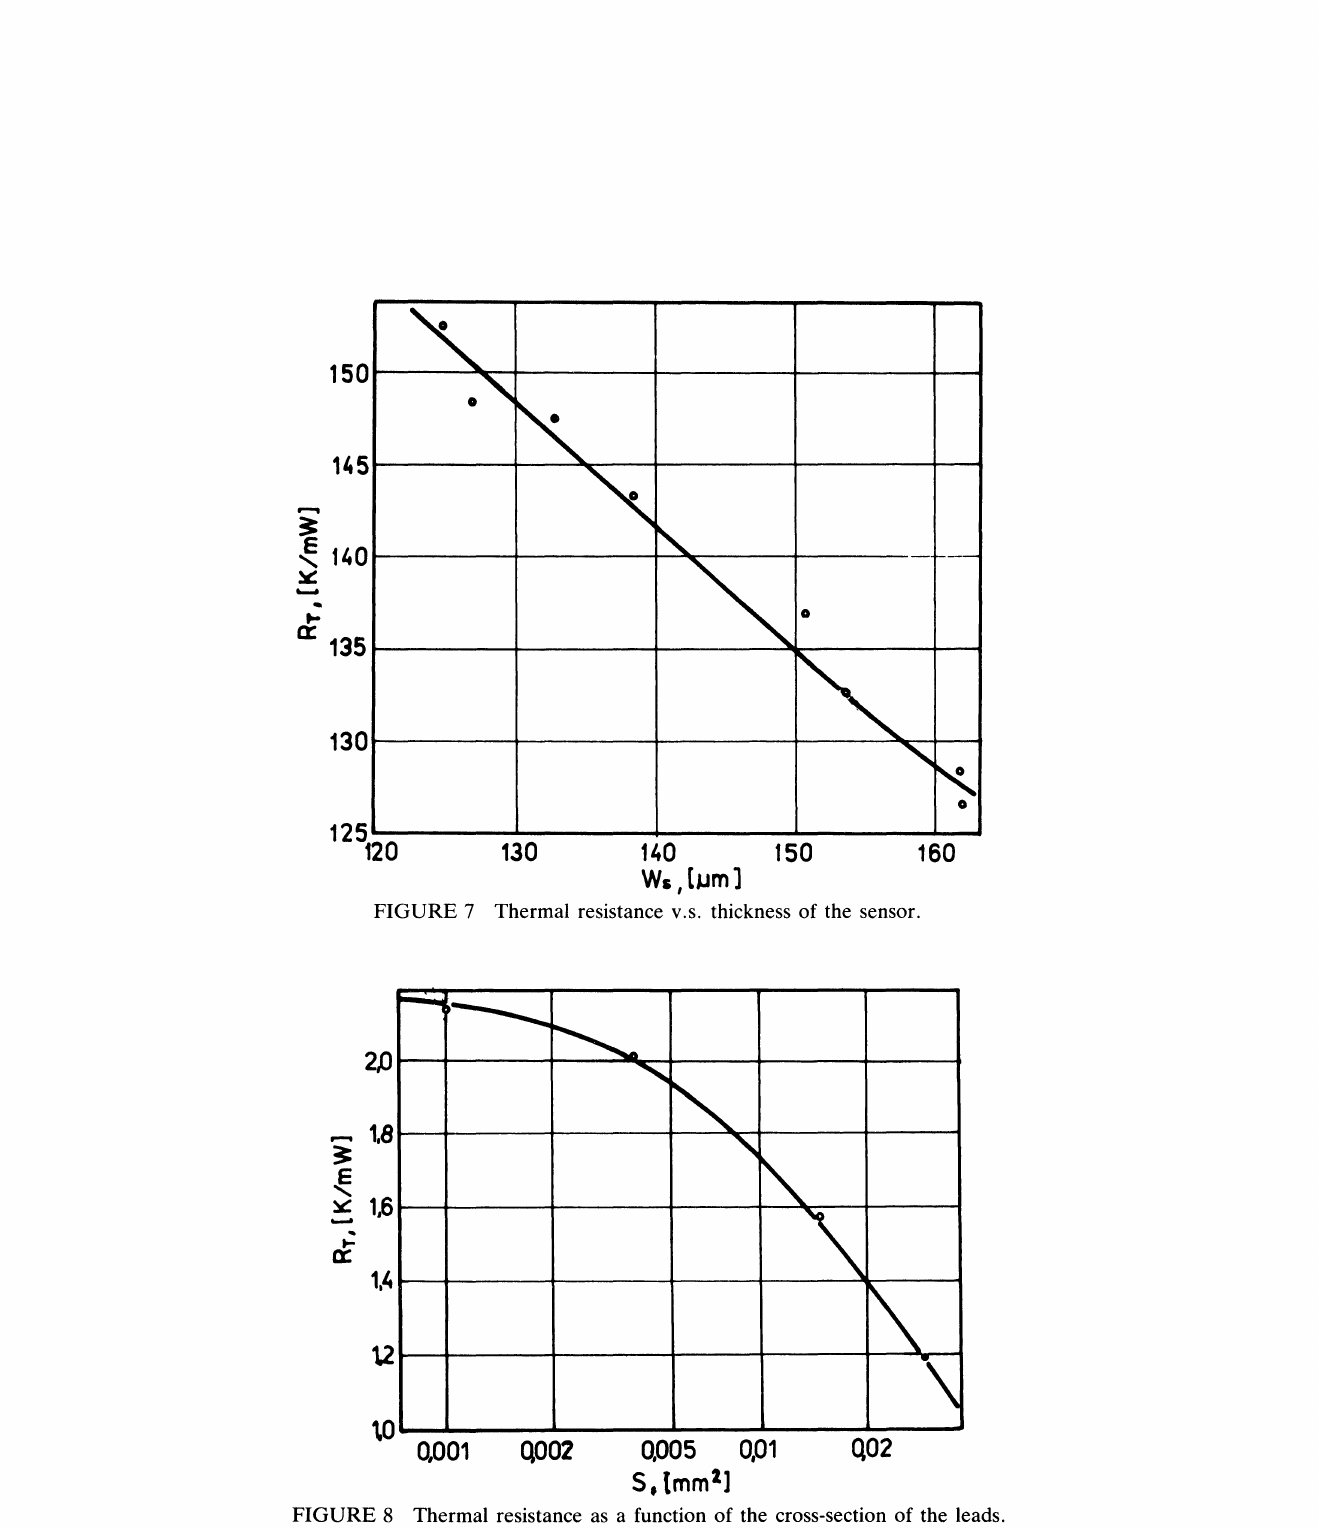
FIGURE 8 Thermal resistance as a function of the cross-section of the